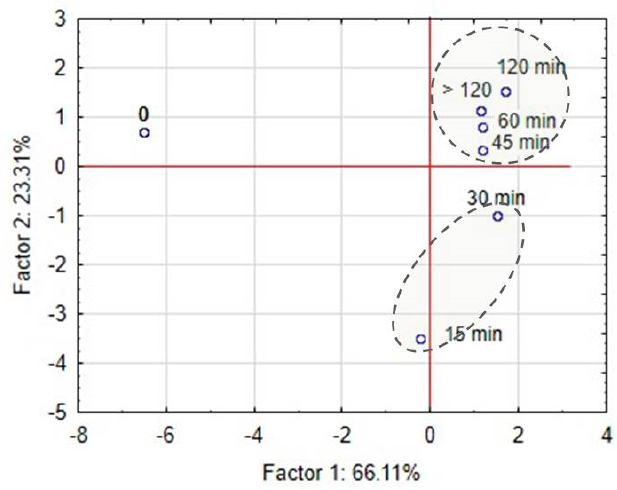
Figure 6. Factor score plot for LH sampled at different treatment times.